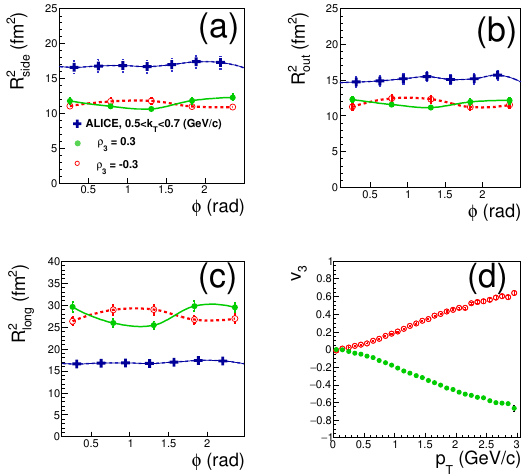
Figure 4. The same as Figure 3, but for calculations with ρ 3 = 0.3 (solid circles) and with ρ 3 = − 0.3 (open circles).